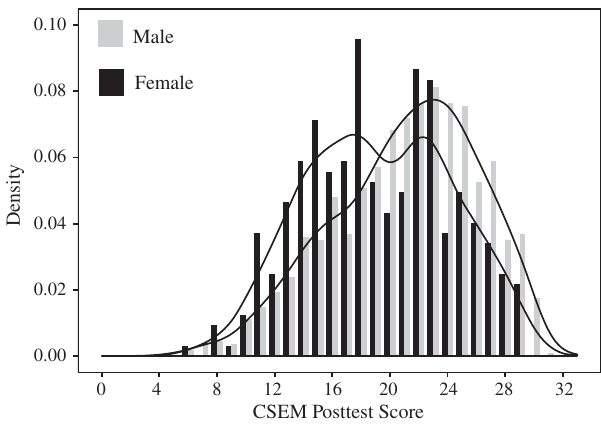
FIG. 2. The distribution of CSEM post-test scores for male and female students. Density plots are drawn for men and women; the male plot reaches its maximum to the right of the maximum of the female plot. The male and female histograms are displaced by the width of one bar so that the histograms do not overlap. The density plots are not